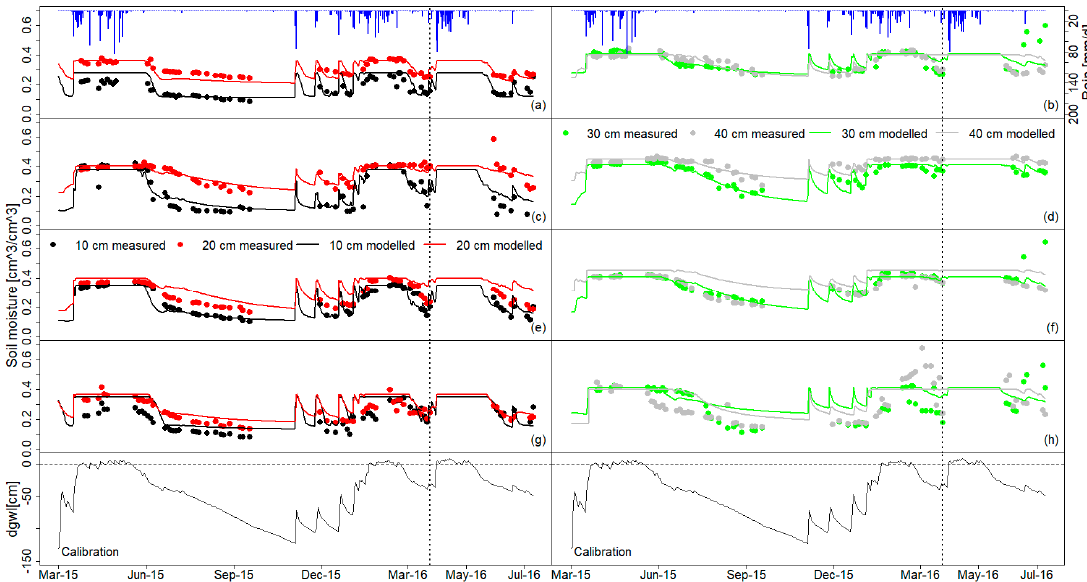
Figure 5. Measured and modeled soil moisture content after calibration at the four plots for the fringe zone. ( a , b ) plot PF_12; ( c , d ) plot PF_10; ( e , f ) plot PF_4; ( g , h ) plot PF_8. dgwl; measured depth to groundwater level. Table 6. Statistical measures of the Hydrus-1D model performance for simulations of soil moisture content at the fringe zone after calibration.